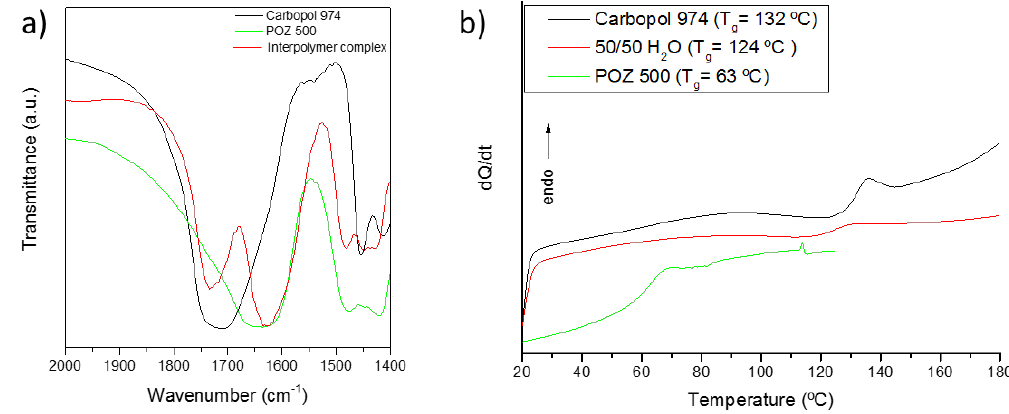
Figure 2. Analysis of Carbopol 974/poly(2-ethyl-2-oxazoline) 500 complex, and pure components by: ( a ) FTIR; and ( b ) DSC.